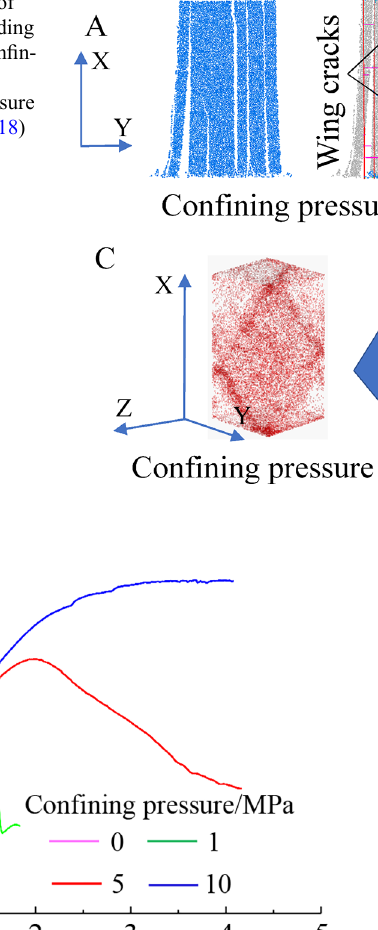
Fig. 13 Fracture geometries